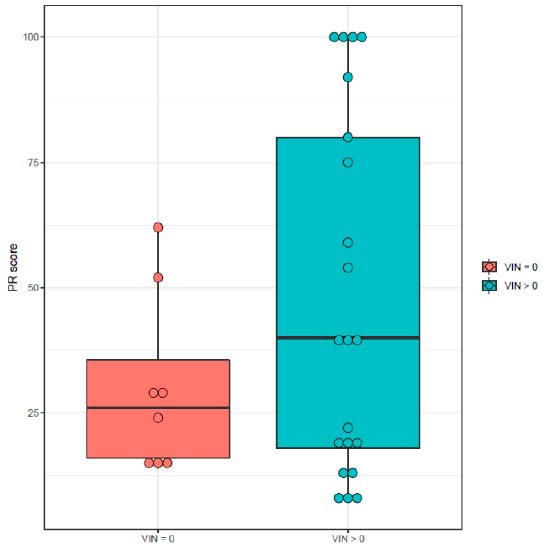
Figure 4. Study groups according to SVIN positivity (VIN > 0) or negativity (VIN = 0) at 12 months after VN and their value of PR score.